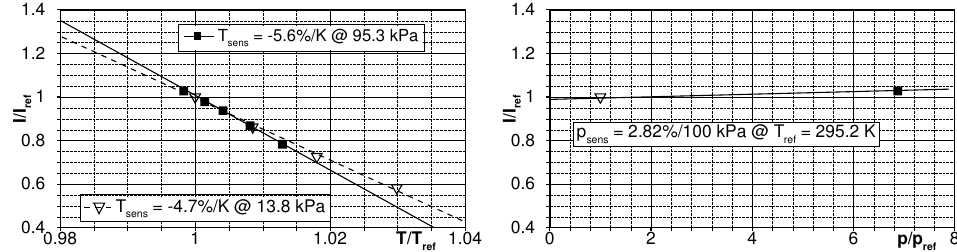
Figure 5. In-situ calibration curves for Ru(phen)-based Temperature Sensitive Paint under different ambient pressures showing the temperature sensitivity ( left ) and the pressure dependency ( right